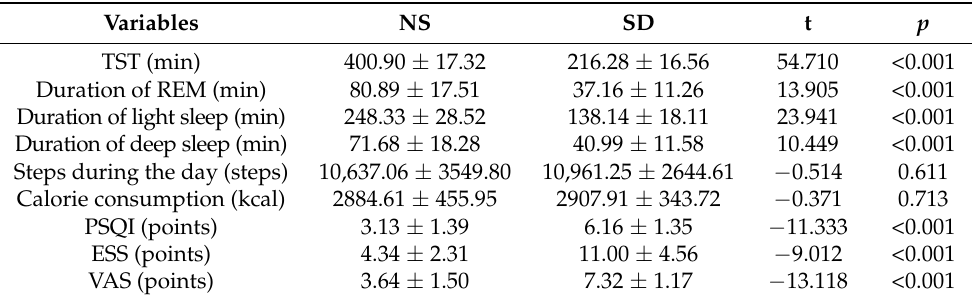
Table 2. The differences in sleep-related factors between NS and